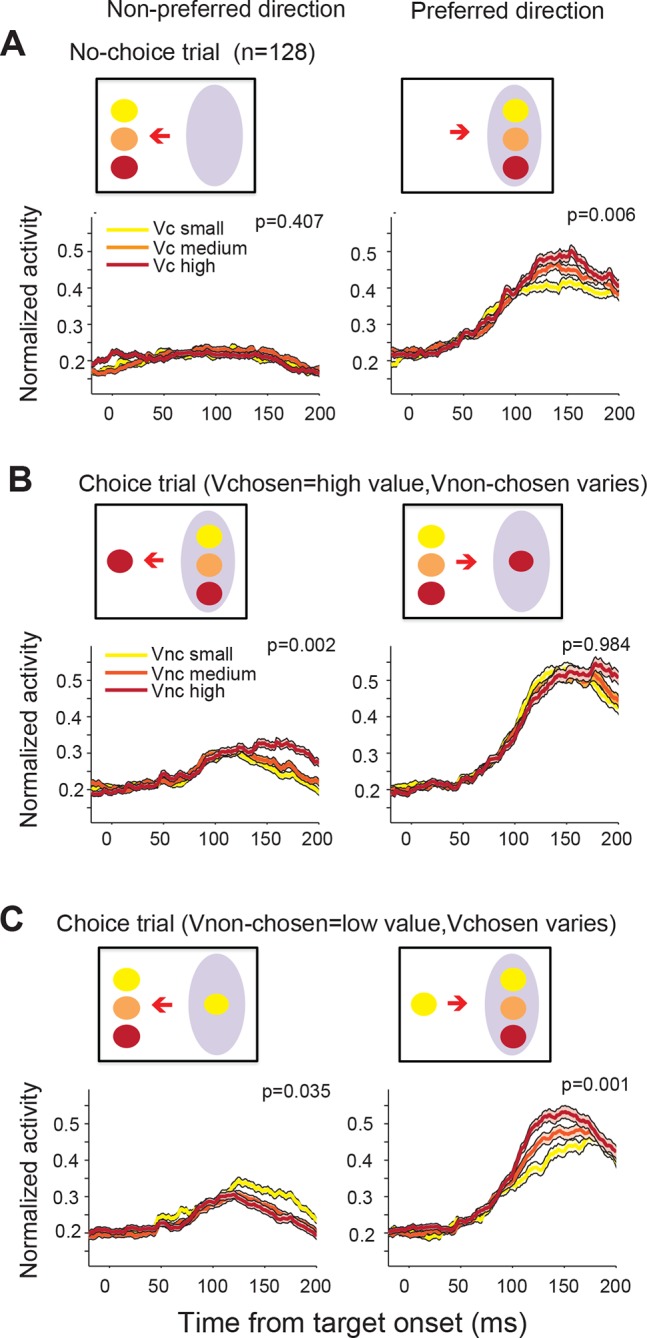
SEF neurons represent the difference in value of targets in the preferred (PD) and non-preferred direction (NPD) independent of the chosen saccade direction.This figure shows the normalized activity of SEF neurons sorted by chosen saccade direction (PD: right; NPD: left) and value of the chosen or non-chosen target. We grouped the subjective value of the reward options into three groups (red: high value; orange: medium value; yellow: low value). The inset above the histograms indicates the location and value of the targets in the trials shown in the histograms below. The grey oval indicates the location of the preferred direction of the neuron, while the arrow indicates the chosen saccade direction. The p-values indicate the significance of a regression using all seven individual target values without grouping. The shaded areas represent standard error of the mean (SEM). (A) The neural activity in no-choice trials. The color of the spike density histograms indicates the target value. As shown in Figure 4A,B, the neurons reflect the value of the PD target, but not of the NPD target. (B) The neural activity in those choice trials, in which the chosen target had the highest possible value (7 units). We chose this reference point, instead of a medium value (as in Figure 4D), because it allowed us to a comparison with the widest possible range of non-chosen target values (indicated by the color of the spike density histograms: high value = 5–6 units; medium value = 3–4 units; low value = 1–2 units). (C) The neural activity in those choice trials, in which the non-chosen target had the lowest possible value (1 unit). Again, this reference point allowed for the widest possible range of chosen target values (indicated by the color of the spike density histograms: high value = 6–7 units; medium value = 4–5 units; low value = 2–3 units). Consistent with Figure 4 in the main text, we can observe that increasing PD target value increases neuronal activity (B: left panel; C: right panel), while increasing NPD target value decreases neuronal activity (C: left panel). This is true, whether the PD or the NPD target is chosen. However, the value of the chosen target has a stronger influence than the non-chosen one, and in the extreme case, when the PD target has the highest possible value and is chosen, the NPD value has no longer a significant effect on the neural activity (B: right panel).